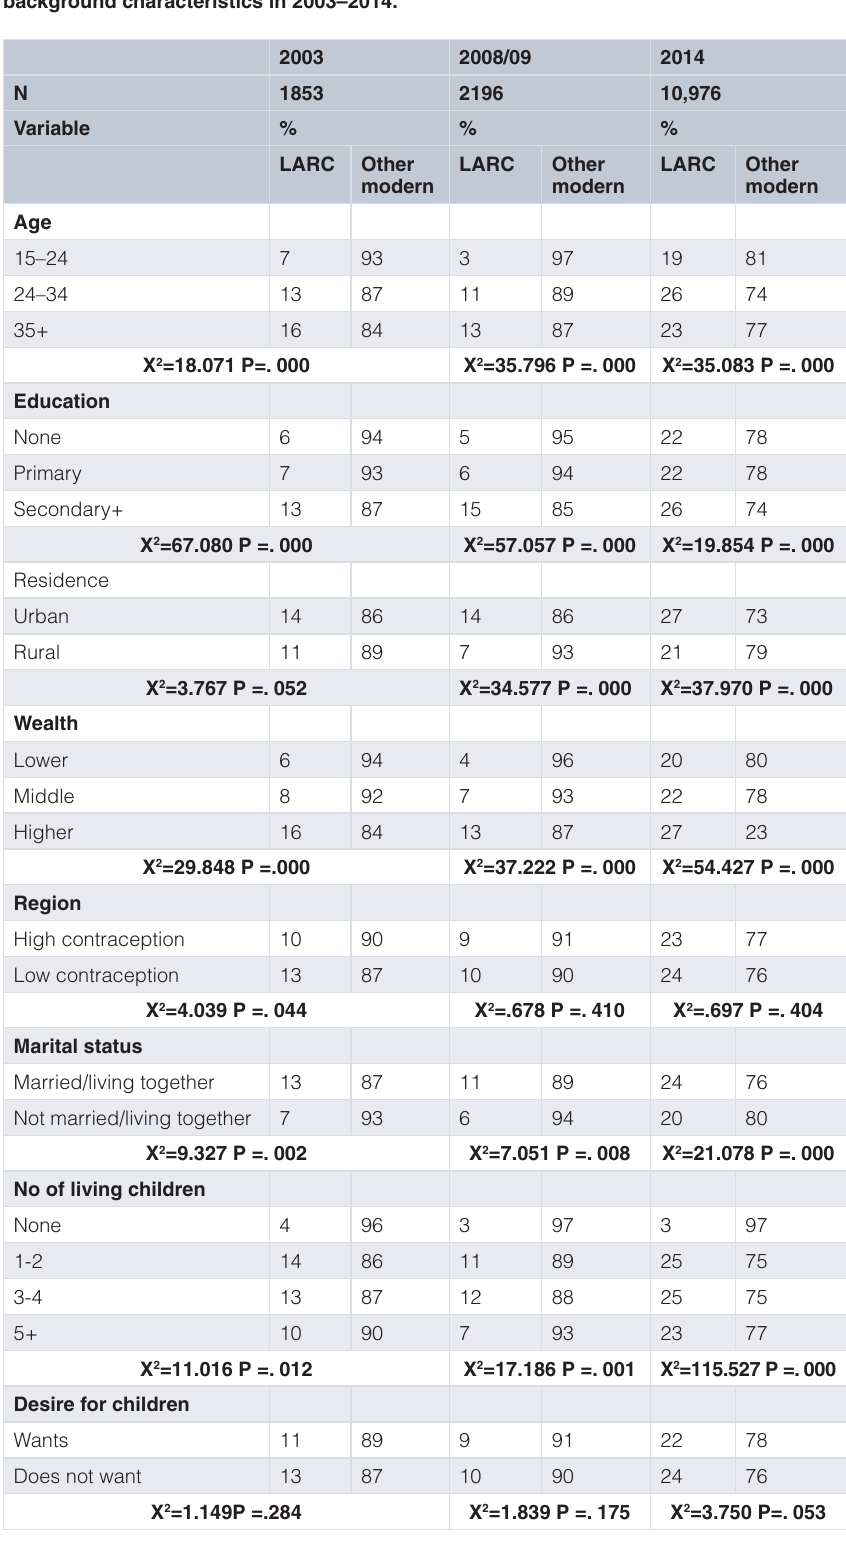
Table 1. Differentials of modern contraceptive use for women aged 15–49 by various background characteristics in